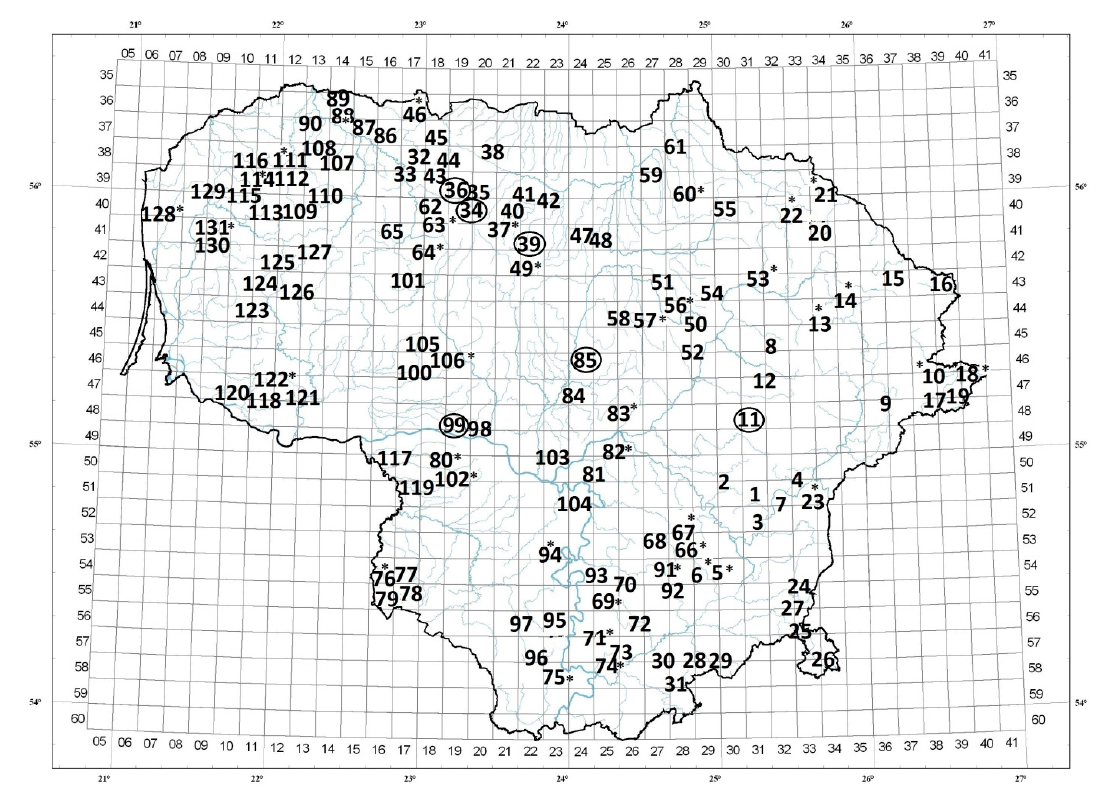
Figure 2. Occurrence of Thymus pulegioides α -terpinyl acetate in Lithuania. α -Terpinyl acetate was found in marked habitats only: habitats marked with a circle amounted ≥ 5% α -terpinyl acetate, marked with *— ≤ 5% α -terpinyl acetate in essential oil. In habitats without mark a-terpinyl acetate was not found.